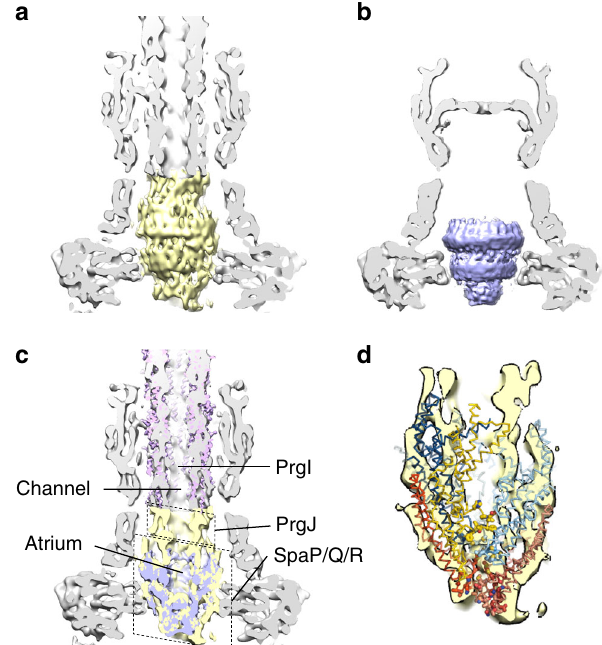
Fig. 2 The export apparatus forms an asymmetric substructure composed of SpaP and SpaQ and SpaR. a The region of the needle complex C1 reconstruction corresponding to the export apparatus and putative rod colored yellow. Slabbed remainder of reconstruction colored gray. b The region of previous C1 basal body reconstruction 7 corresponding to the export apparatus colored purple. The map features a fl at, symmetrical pore, averaged out by the signal of the 24-mer IM rings (24-mer repeating features evident on upper surface). Slabbed remainder of reconstruction colored gray. c Slabbed view of overlay of a and b showing export apparatus region from needle complex map (yellow) is asymmetric compared to the same region from the basal body map (purple) (lower box). The 3.3 Å needle map (magenta) fi ts well (correlation coef fi cient = 0.95) into the wider part of the fi lament density. We propose the boxed narrower region between the base of the fi lament and the export apparatus represents the PrgJ rod, which has been proposed to form a short adaptor between export apparatus and needle 22 . d The recent structure of the Salmonella fl agellar export apparatus 23 FliP (blue)/Q (red)/R (yellow)) forms a complex with stoichiometry of 5:4:1 and overlays very well with the needle complex export apparatus substructure. The subunits form a helical assembly ideal as a structural foundation for the assembly of the rod and needle fi